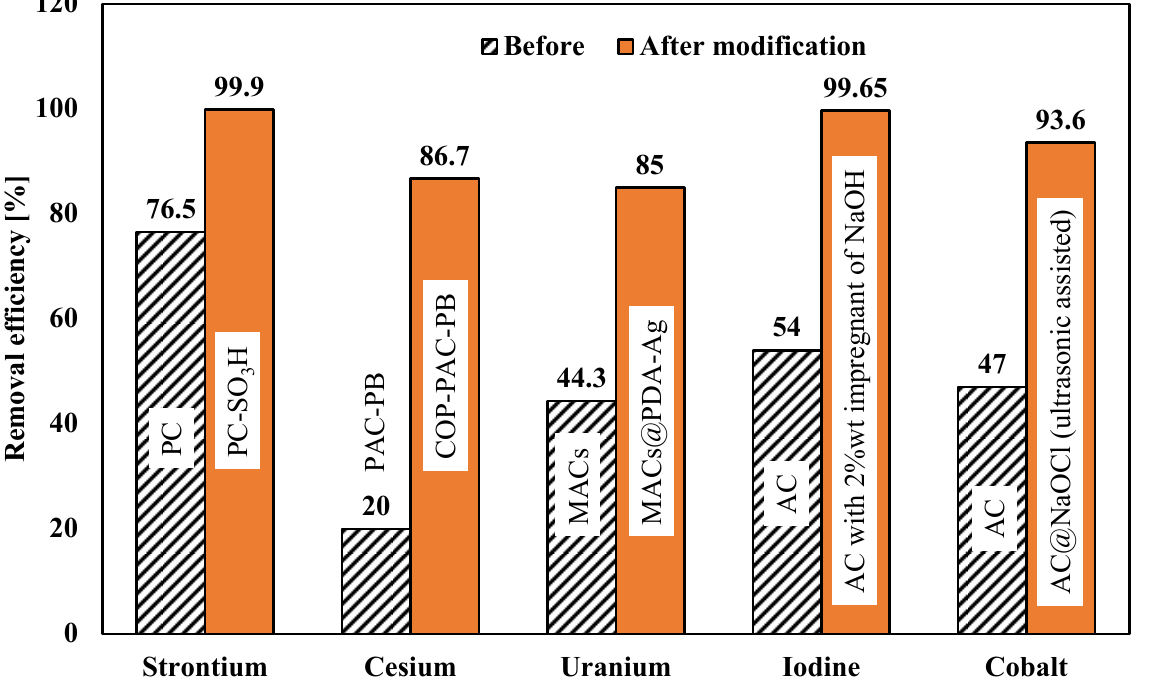
Figure 10. Comparison of radionuclide removal efficiencies before and after modification of parent activated carbon.